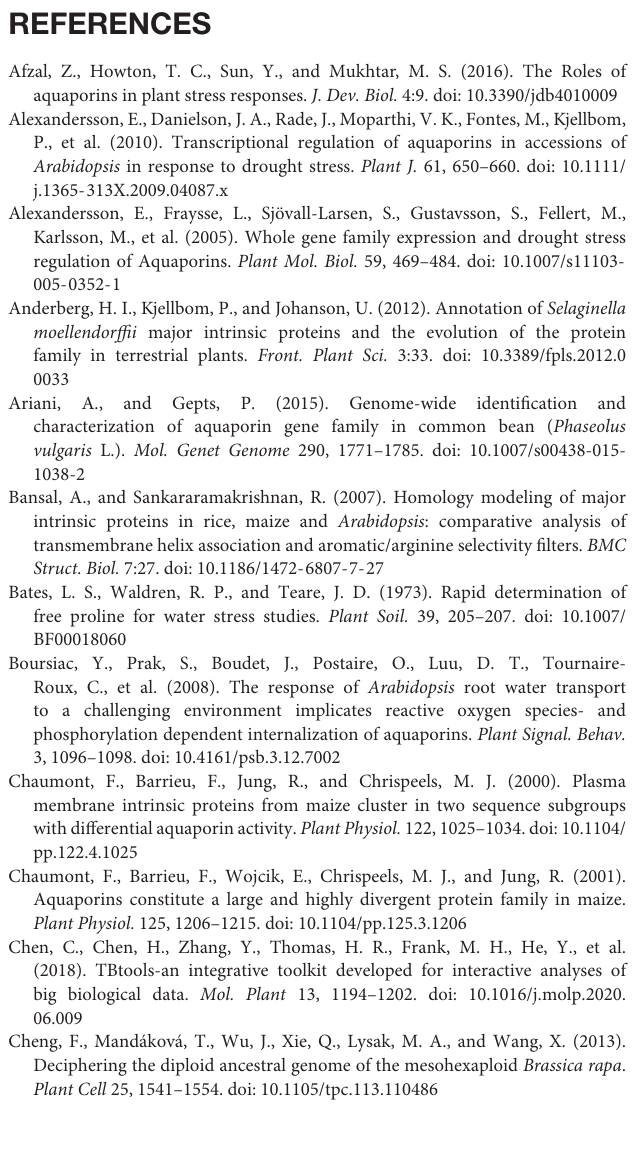
subfamily. Supplementary Table 8 | Amino acid sequences of AQP genes in